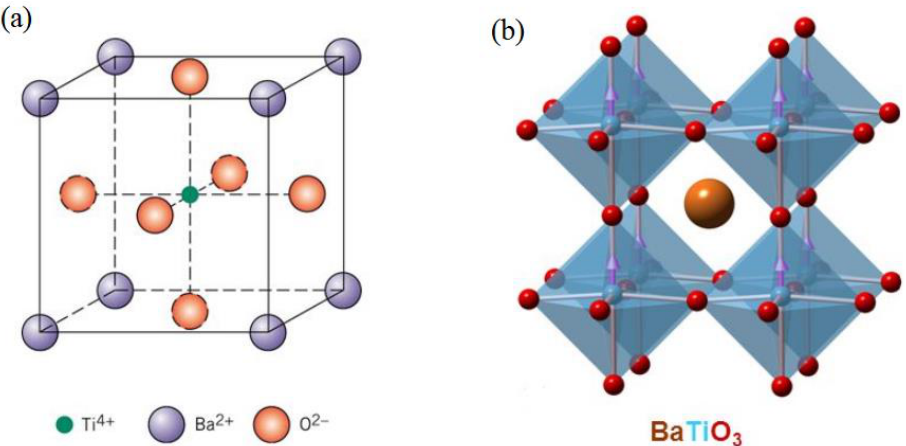
Figure 2. The cubic phase for BaTiO 3 unit cell ( a ). Here Ba 2 + ions occupied the corner of the cube, O 2 − lies in the center of the phases for the composition, Ti + 4 lies in the center of the composition. 3D view of BaTiO 3 perovskite crystal structure ( b ), image taken from http://slideplayer.com/slide/9010945/.